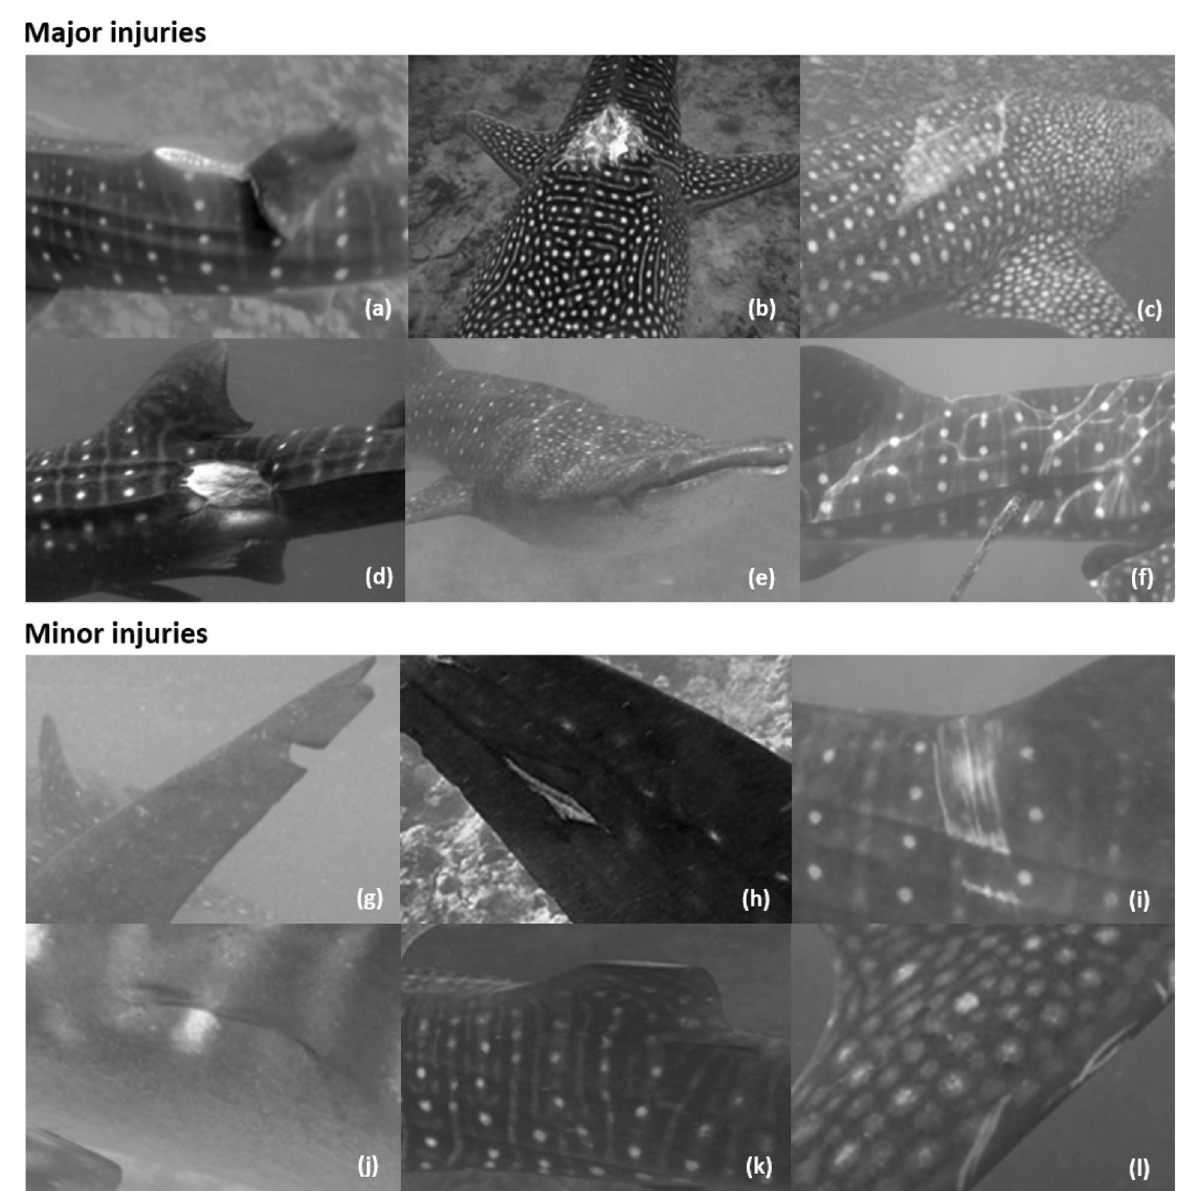
( c ) abrasion, ( d ) bites, ( e ) blunt trauma, ( f ) impalement. Entanglement not shown. Minor injuries—( g ) amputation, ( h ) laceration, ( i ) abrasion (penetrating outer dermal layer), ( j ) bites, ( k ) deformity and ( l ) scratch. Images taken by